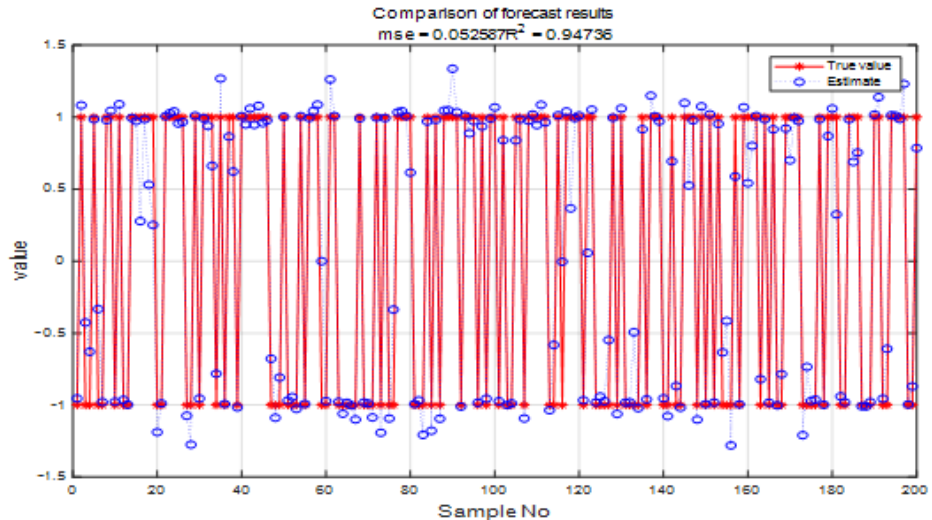
Figure 6. Comparison between predicted value and true value of test sample.